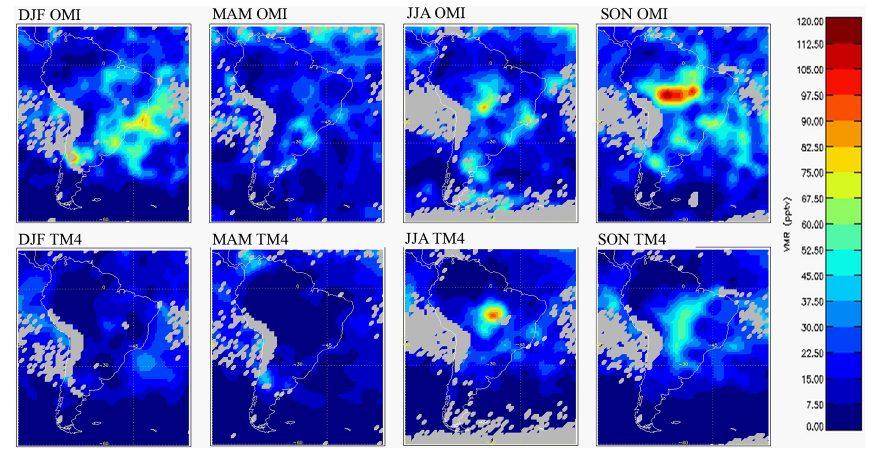
Figure 22. Same as Fig. 19 but at 620hPa.